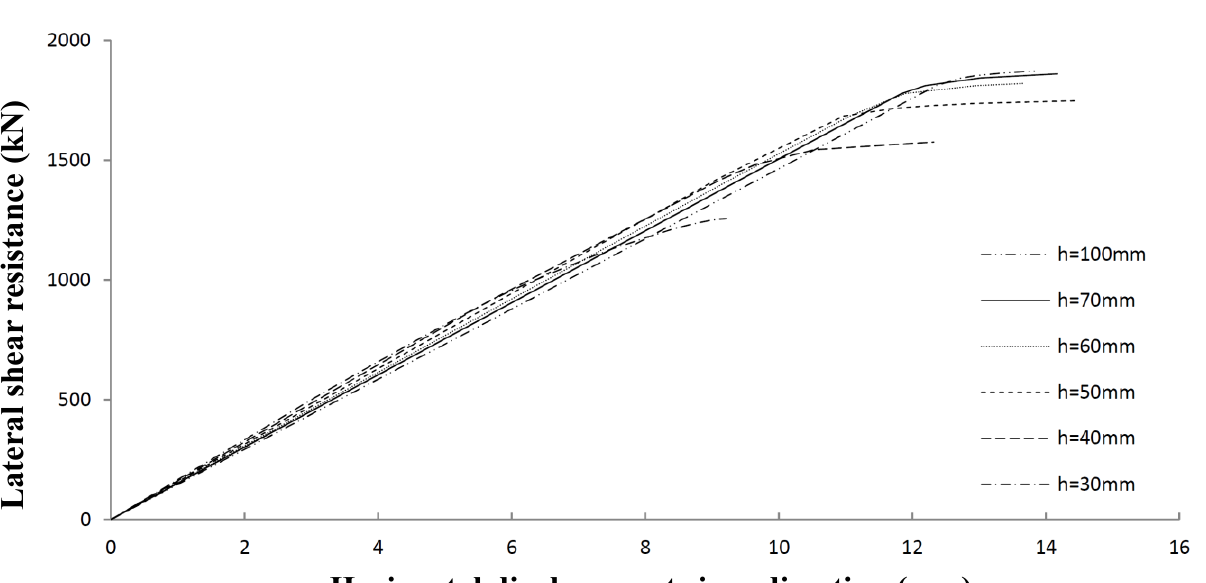
Figure 21. Lateral shear resistance of Panel 4 with varying profile heights.